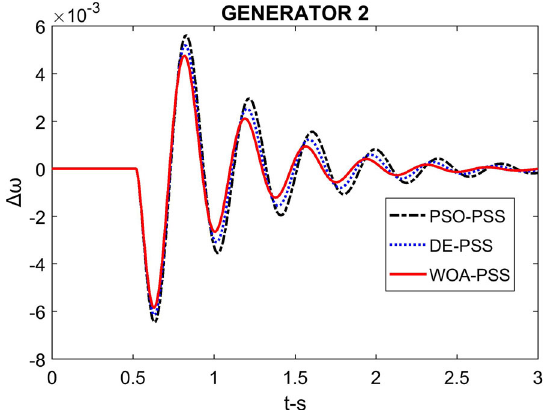
Where l is a random number varies between 0 and 1. To combine both shrinking circle path and spiral path, here 50% probability is given for the paths to update the positions of the whales. Finally search agent follows the equation below.